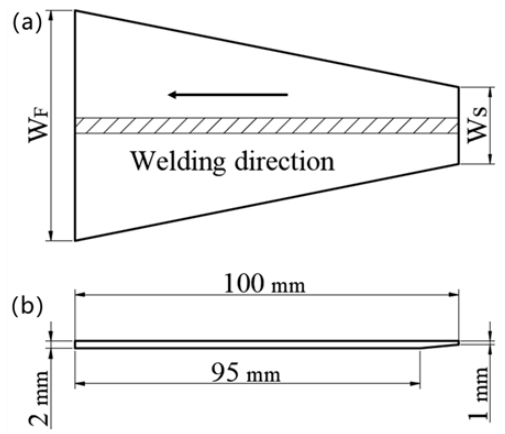
Figure 2. Schematic image of the specimen of the new test method—“Trapezoidal hot” cracking test. ( a ) The front of the specimen; ( b ) the profile of the specimen.